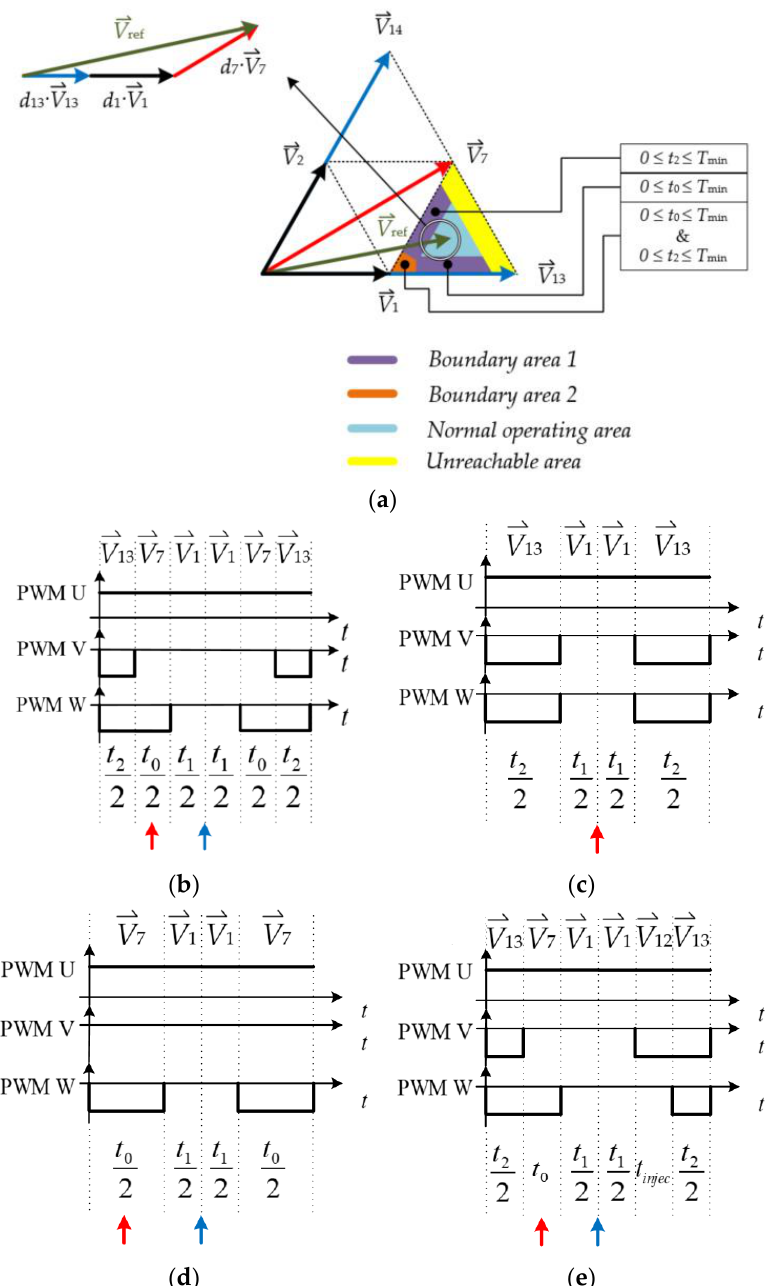
Figure 11. ( a ) Vector diagram for Sector 1 and Region 3 with marked problematic areas for single- shunt measurement; ( b ) SVM pattern for Sector 1 and Region 3 inside the normal operating area; ( c ) SVM pattern while t 0 = 0 s; ( d ) SVM pattern while t 2 = 0 s; ( e ) proposed SVM modification pattern while t 0 < Tmin.